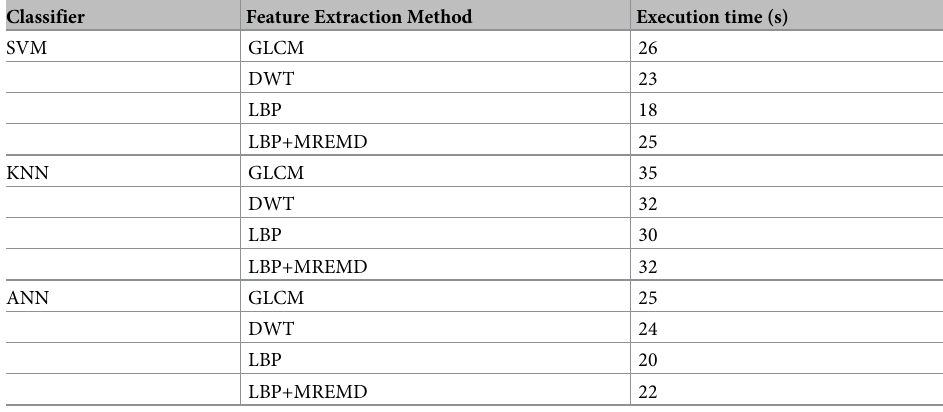
Table 4. Execution time for different classifier and feature extractor.